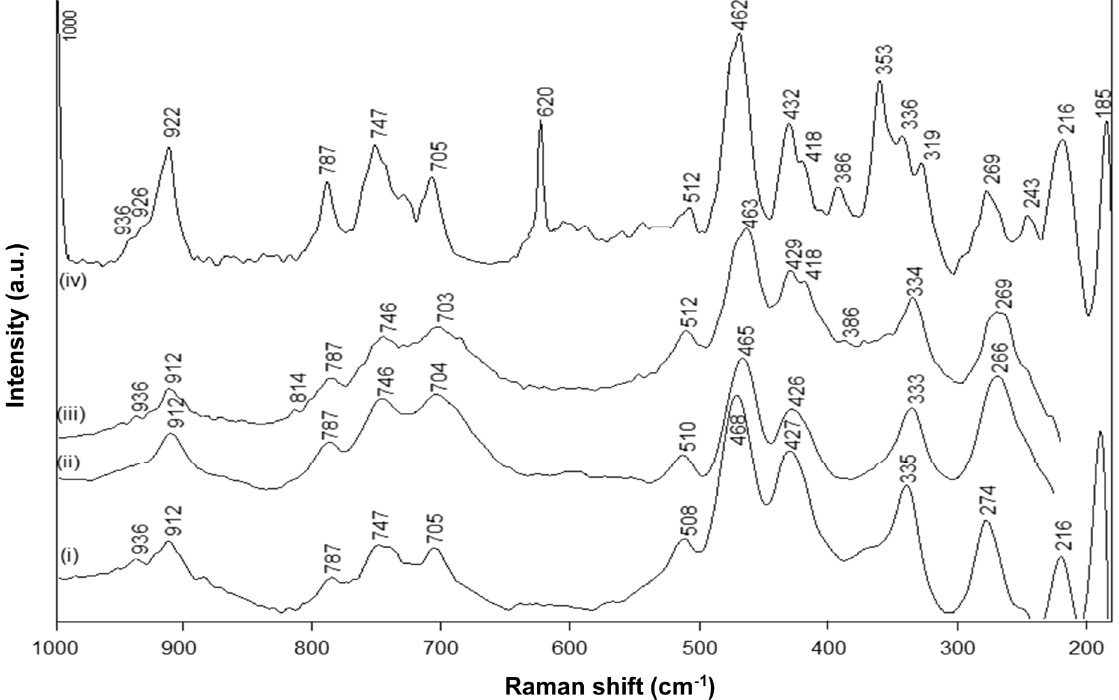
Figure 6. FT-Raman spectra for ( i ) Kln, ( ii ) Kln/DMSO 20 h, ( iii ) Kln/DMSO + water 10 h, ( iv ) Kln/a-SMA =